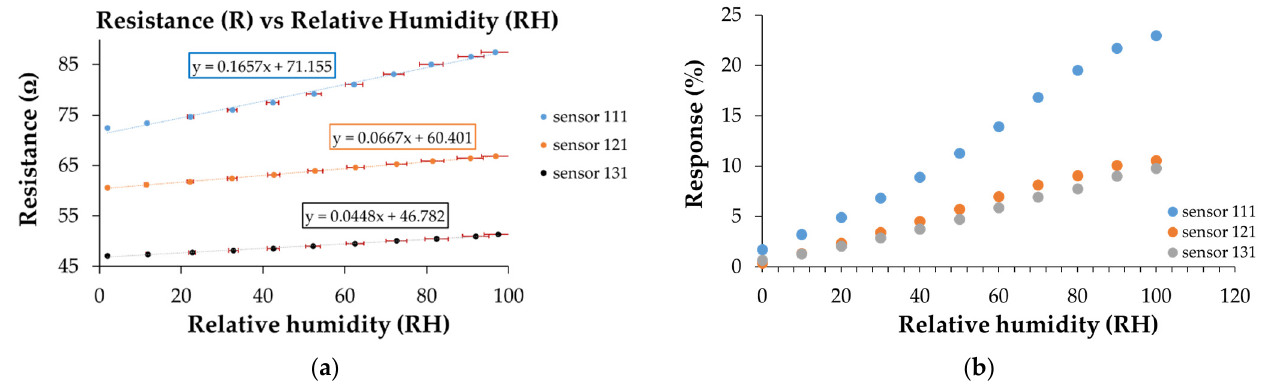
Figure 13. ( a ) The transfer function, in the second run, of the sensors in humid nitrogen (RH = 0–100%); ( b ) the humidity sensing response (%) varies with the amount of deposited CNHox.